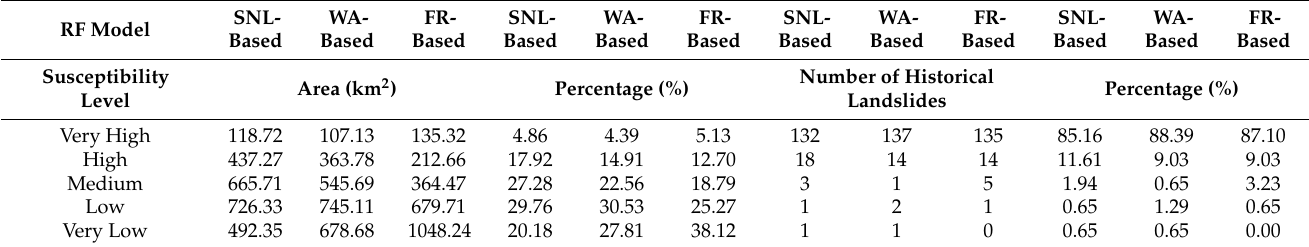
Table 1. Distribution of landslides within different susceptibility